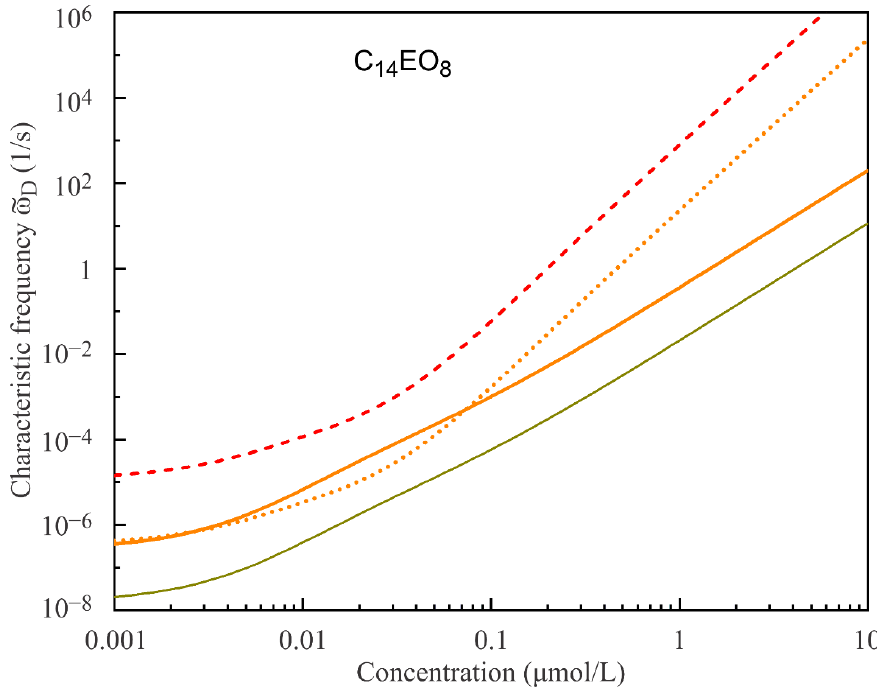
Figure 7. Characteristic frequency D (c) for C 14 EO 8 solutions calculated assuming various number of states s (orange dotted line for s = 2 and orange solid line for s = 10) with the parameter sets presented in Table 2 and the diffusion coefficient D = 8.7 ∙ 10 − 9 m 2 /s. Also shown are the theoretical curves for different diffusion coefficients and the same other parameters: D = 3 ∙ 10 − 7 m 2 /s (red dashed line for s = 2) and D = 5 ∙ 10 − 10 m 2 /s (green solid line for s = 10). For details, see text.